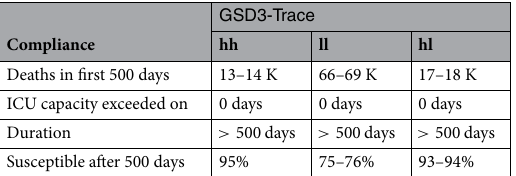
Fig. 2. The fact that the epidemic progresses more slowly in this case implies that ICU capacity is exceeded for more days as compared to the case where both groups show low compliance. For the same reason it is exceeded by a smaller amount on most of these days, especially at and around the peak; see top panels of Fig. 3. If we add tracing onto a scenario with uniform or group-specific social distancing ( USD1-Trace and GSD3- Trace ; see Tables 9 and 10 ), we see similar patterns, but in a context where there is substantially less strain on the health system compared to the benchmark scenarios. The death toll is significantly reduced compared to the respective scenarios without tracing if compliance is high—but not if it is low. Interestingly, if only the group with low vulnerability has a high take-up rate, and social distancing is in place, the death toll is close to the death toll under generally high compliance if group-specific social distancing is in place. The numbers also show that even